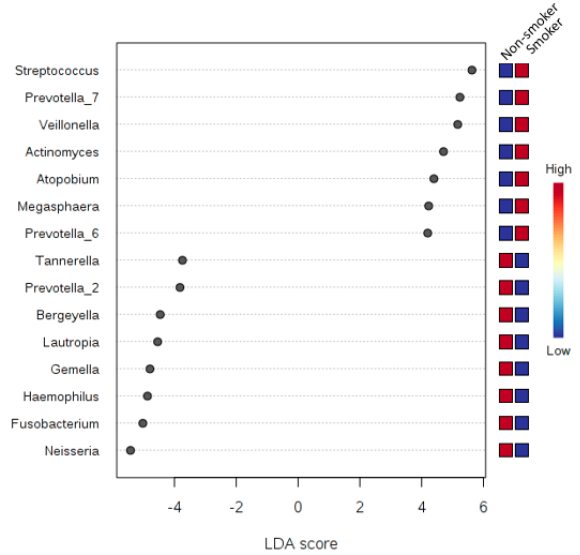
Figure 7. A plot of the LDA scores of the top 15 genera showing statistically significant differences between smokers and non-smokers. LDA scores on the x -axis and genera on the y -axis. The color-coding in the squares of the right side of the plot refers to the cumulative abundance of each genus in each binned group, where red means high cumulative abundance and blue means low cumulative abundance.